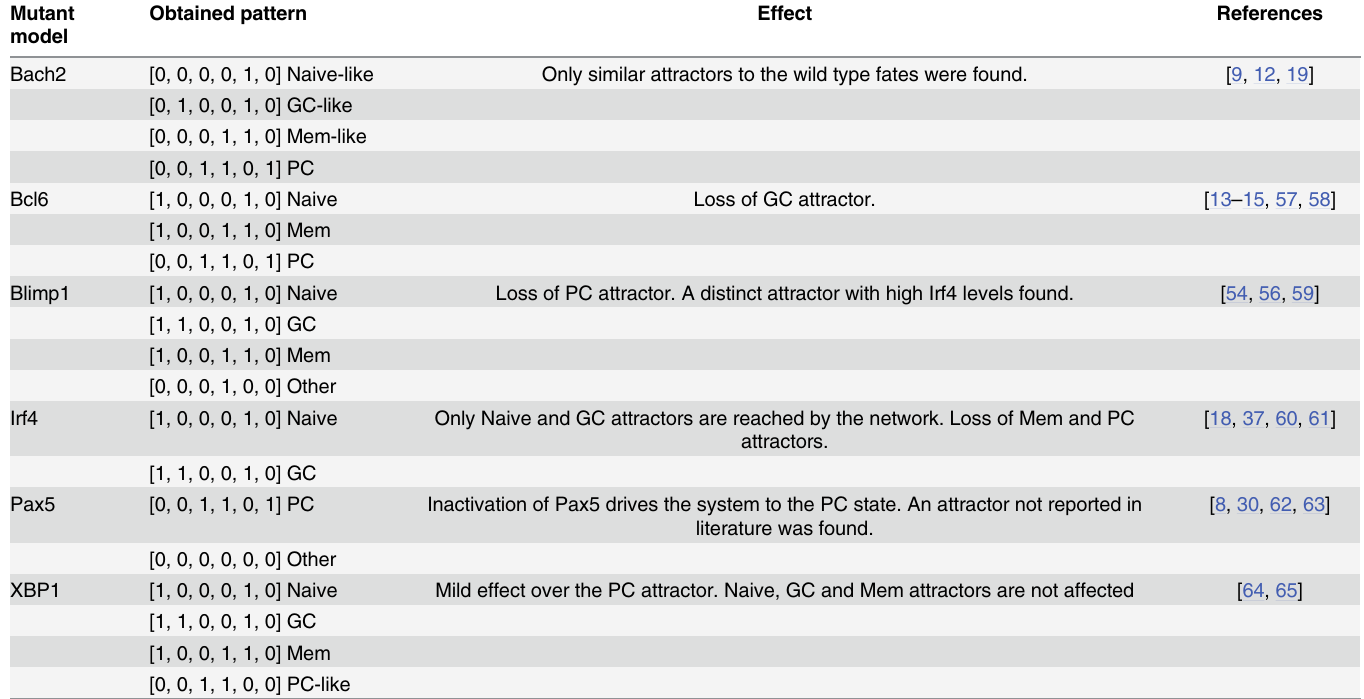
Null mutant attractors. The attractors found for each null mutant model and the literature supporting its effect are summarized, for simplicity, only the patterns of activation for the nodes that conform the core of the network, namely Bach2, Bcl6, Blimp1, Irf4, Pax5 and XBP1 are shown. The steady state pattern for each mutant is shown in the following order: [Bach2, Bcl6, Blimp1, Irf4, Pax5,